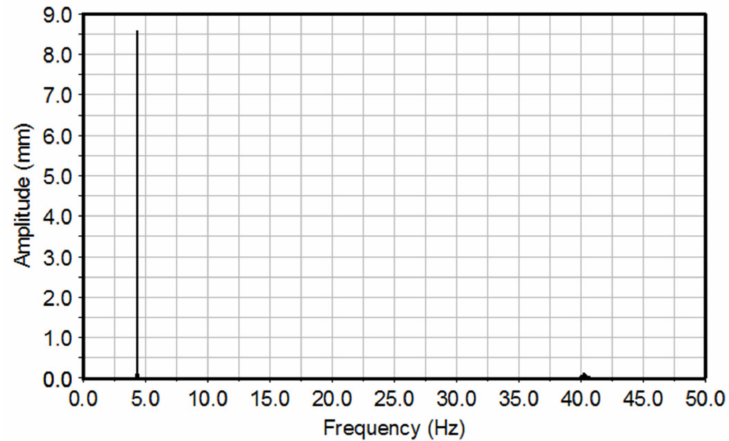
Figure 11. FFT transform of the flexible arm terminal amplitude.